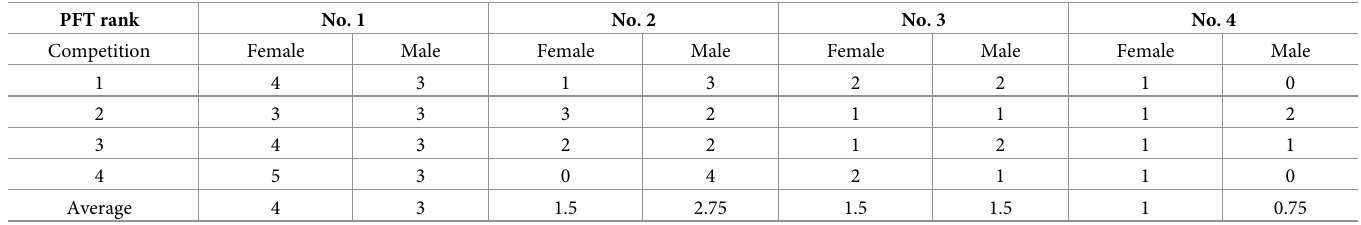
Table 5. Frequency statistics of top 4 athletes with different PFT rankings winning the first